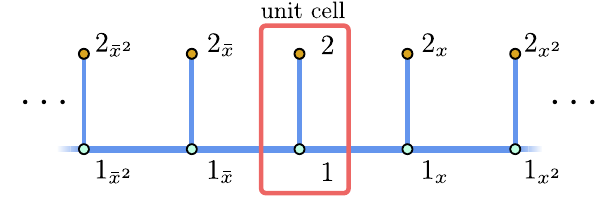
FIG. 1. Translation-invariant comb graph. We denote the translation of a graphical structure by a subscript (e.g., the trans- lation of vertex “1” by one unit cell in the x direction by 1 x , two , and so unit cells by 1 x 2